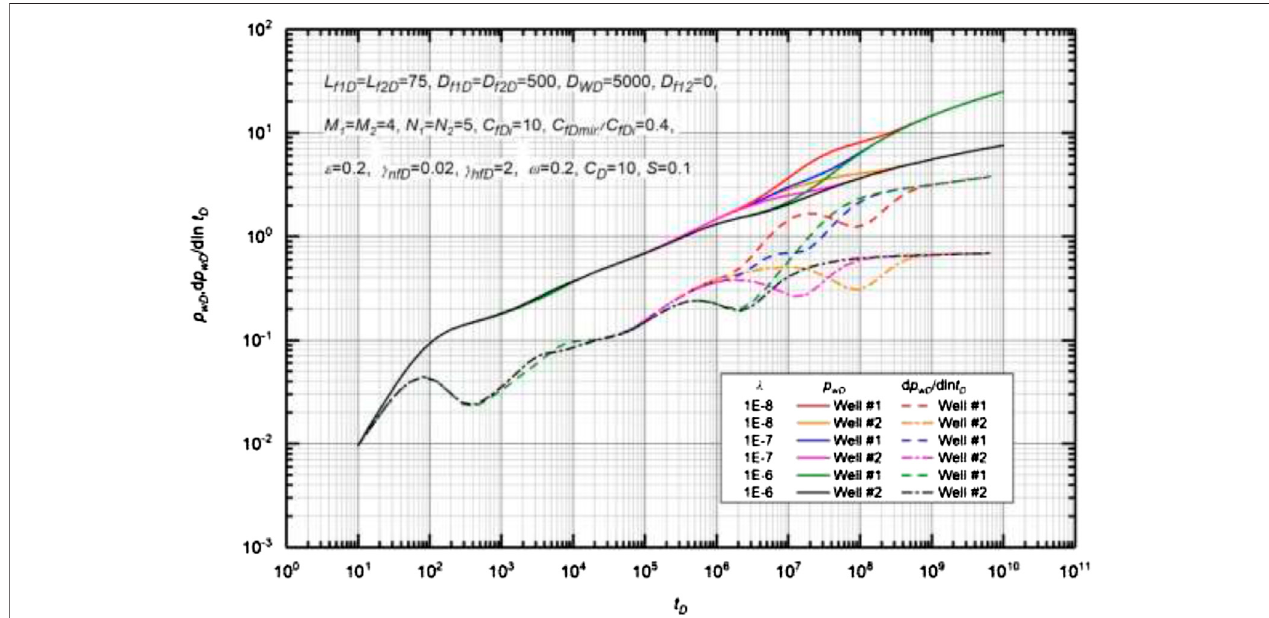
FIGURE 14 | Effect of cross fl ow coef fi cient on the transient pressure for